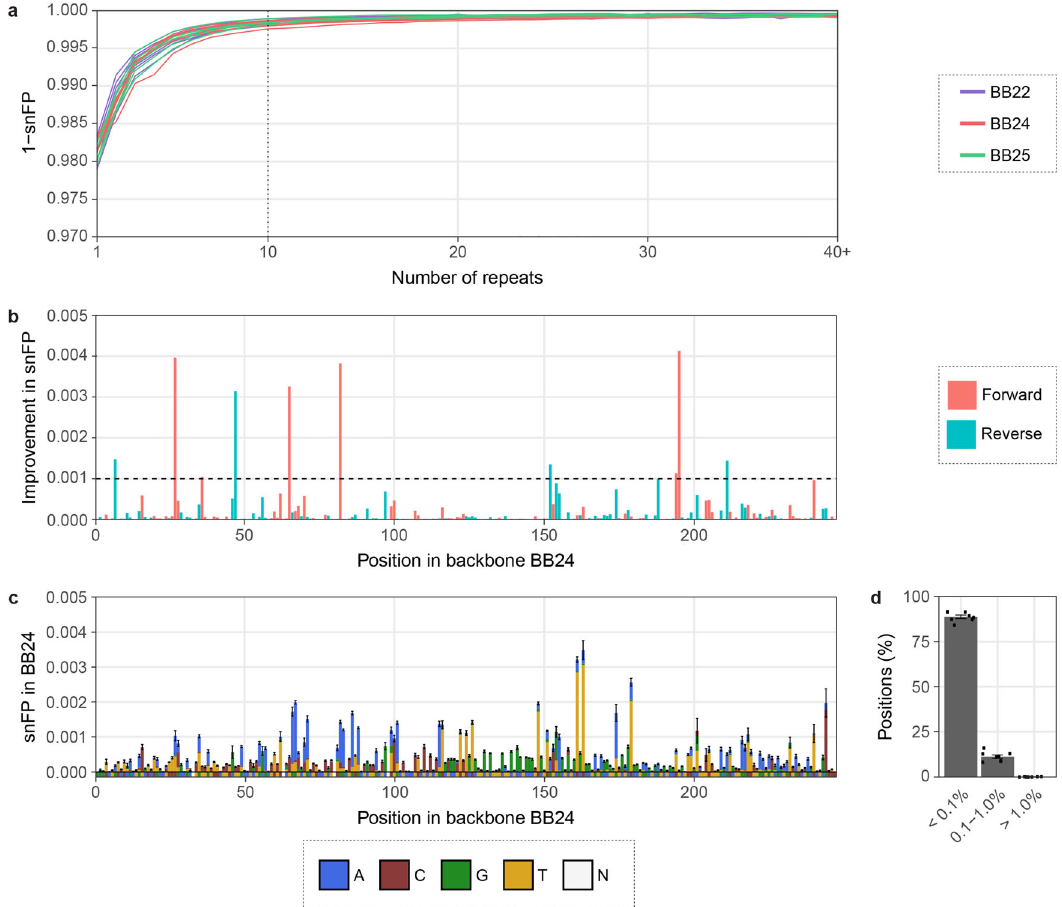
Fig. 3 Consensus calling increases the accuracy of base calling in the backbone. a 1 - single-nucleotide false positive (snFP) rate in backbones (BB22, BB24, and BB25) per number of repeats. The dashed line indicates 10 repeats. Colors represent backbone type. b Mean improvement in snFP rate in BB24 if only the forward or the reverse reads are taken into account. The dashed line indicates an improvement of 0.1%. Colors represent read orientation. c Mean snFP rate across BB24 in reads with at least 10 repeats. Reference sequence is depicted below the x-axis. Colors represent base type. N = any. d Percentage of positions in BB24 with indicated snFP percentage. Data points represent individual sequencing runs. 6 BB22, 8 BB24, and 5 BB25 runs were used for the calculations. Error bars indicate the standard deviation